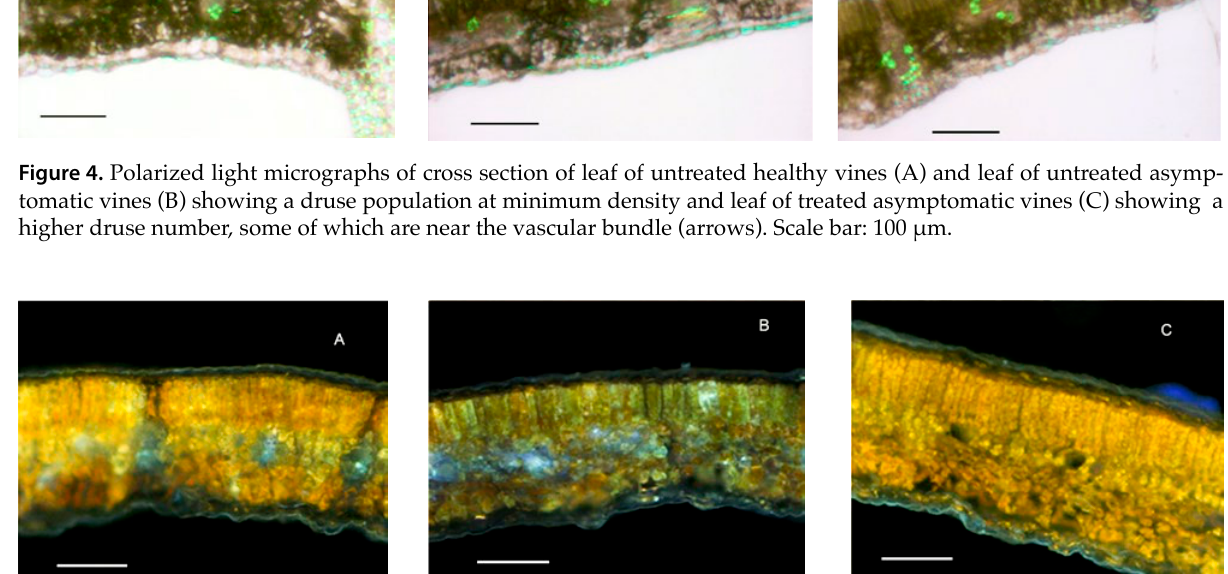
Figure 5. Fluorescence micrographs of cross section of leaf of untreated healthy vines (A) and leaf of untreated asympto- matic vines (B) showing a light yellow fluorescence not evenly distributed in the tissues, and leaf of treated asymptomatic vines (C) with bright and uniform yellow fluorescence. Scale bar: 100